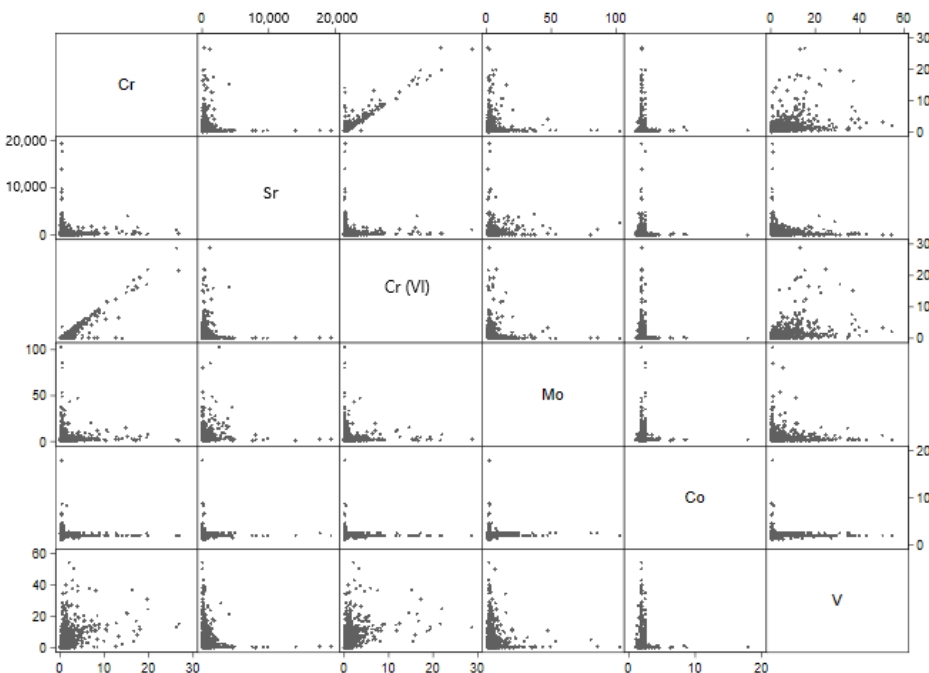
Figure 2. Predicted small public water system-level geometric means of contaminants. Small water system-level predicted geometric means were obtained from mixed-effect Tobit regression models fitted to each contaminant separately, with two random intercepts accounting for nesting of water samples within water systems within states. Each axis corresponds to the contaminants’ range of predicted geometric means (µg/L).